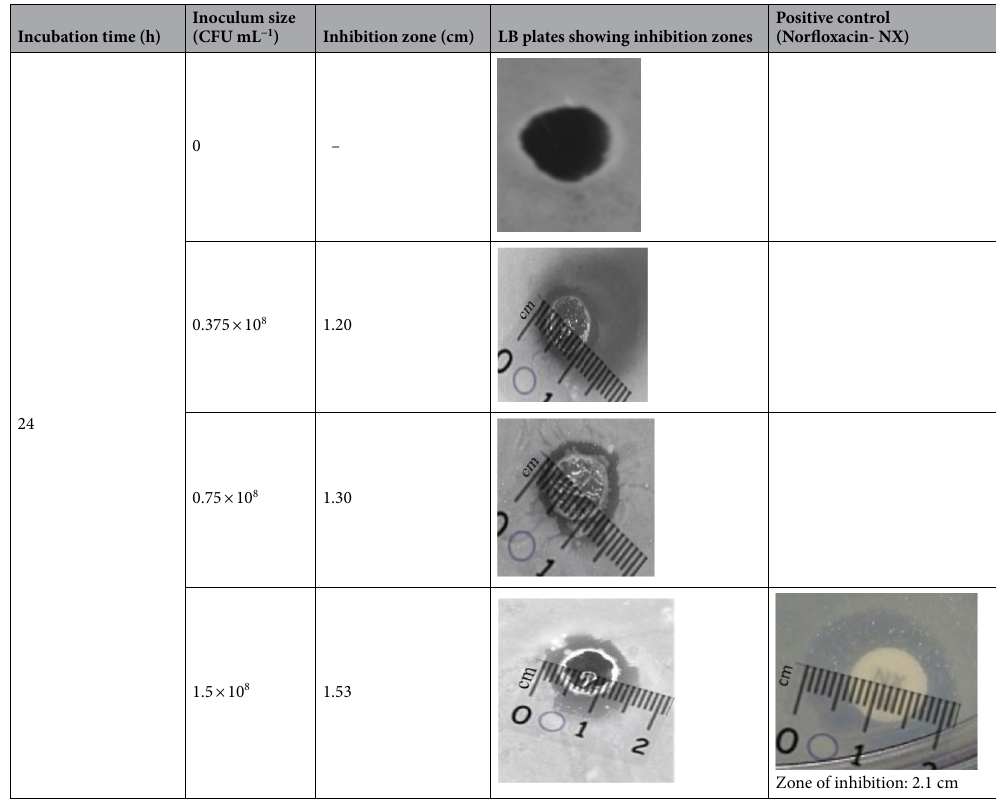
Table 1. Effects of incubation time and inoculum size on AMP production by B. mori L., and its antibacterial properties against P.aeruginosa (ATCC